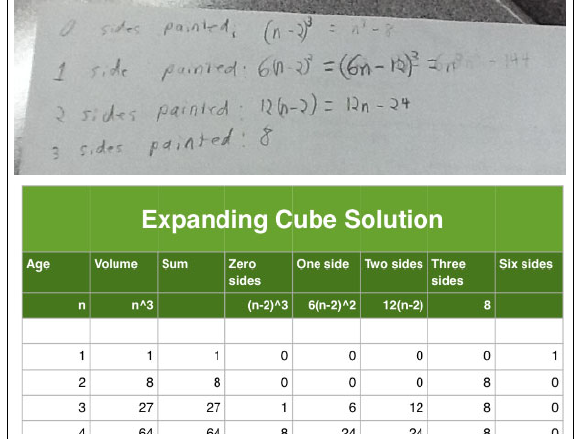
Figure 2. Students used the iPad to verify their formulas. The image on the top shows the formulas developed in paper. In the bottom an example of the use of the spreadsheet is presented.